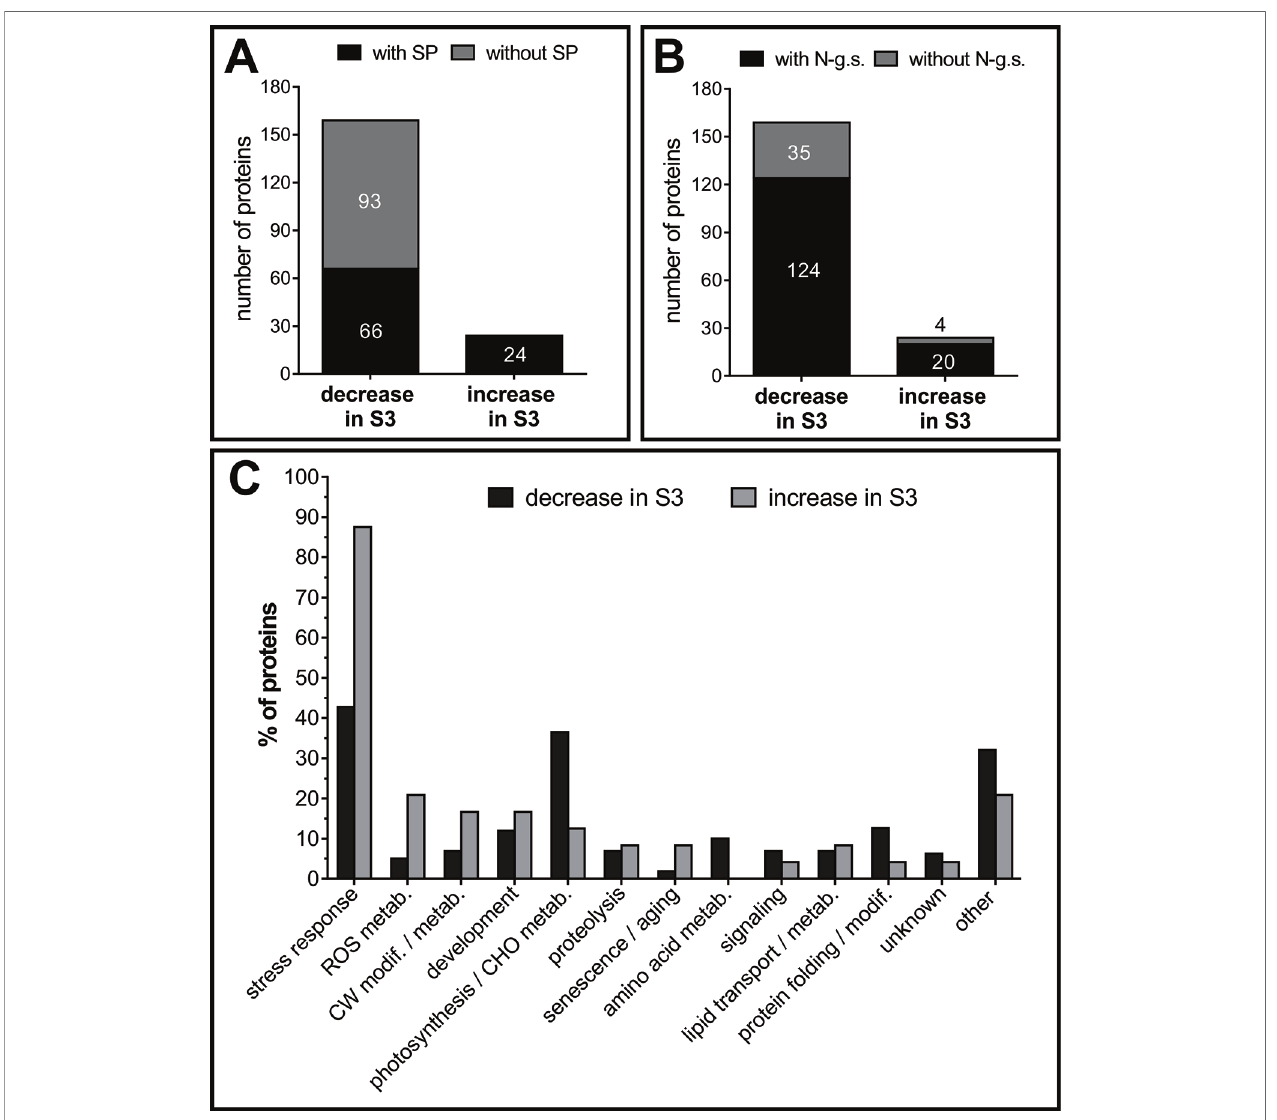
FIGURE 7 | Classi fi cation of AF proteins. Presence of signal peptide, SP, (A) and potential glycosylation sites (B) . Numbers inside and outside the bars indicate the number of proteins. (C) Functional classi fi cation of AF proteins. Proteins with several known functions were assigned to more than one functional group. Values refer to the percentage of each functional group within the group of proteins that decrease in S3 and within the group of proteins that increase in S3. SP, signal peptide; N-g.s, potential N-glycosylation sites; CW, cell wall; ROS, reactive oxygen species; modif., modi fi cation; metab, metabolism; CHO,